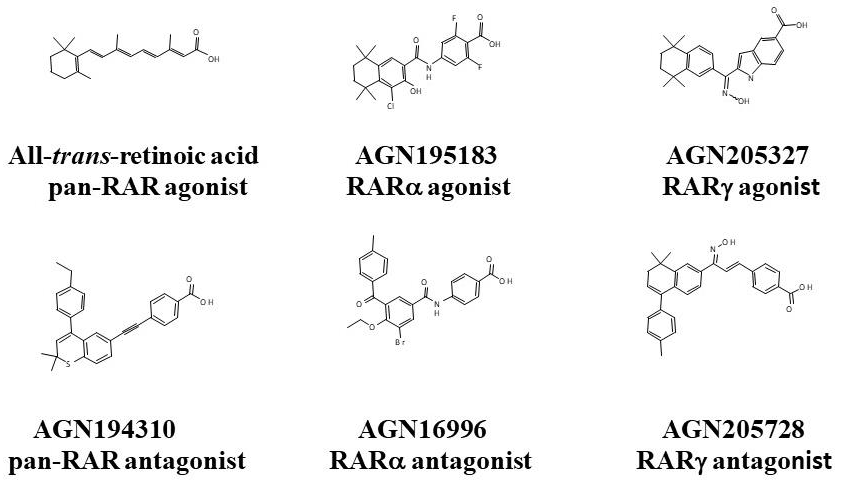
Figure 2. Structures of the RAR agonists and